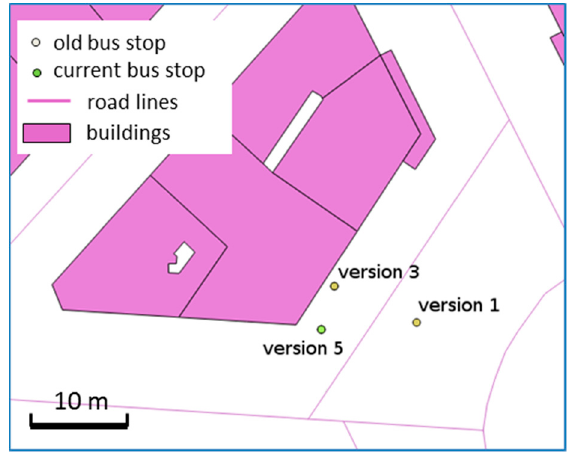
Figure 18. Evolution of bus stop location: the bus stop did move between version 1 and 3, but version 5 is just a better placement as version 3 was too close to the building boundary (©OpenStreetMap contributors).